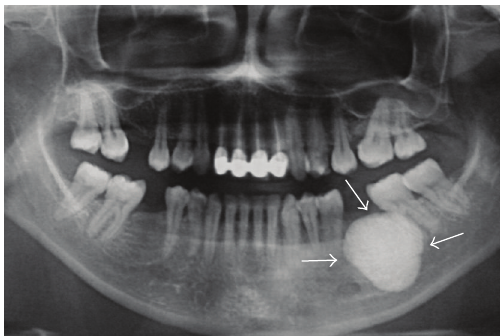
Figure 3: Panoramic radiograph showing a solitary, round, 3 × 3 cm well-defined radio-opaque mass without a radiolucent rim on the left side of the body of the mandible. The lesion extended distally of the second premolar till the mesial aspect of the second molar distal